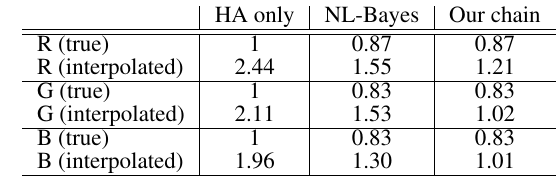
Table 1. Root Mean Squared in VST space (1 being the true noise level) comparison between input simulation image and restored image over a pool of 50 images for random noise iterations. Our chain outperforms NL-Bayes for interpolated pixels due to an ad- ditional denoising